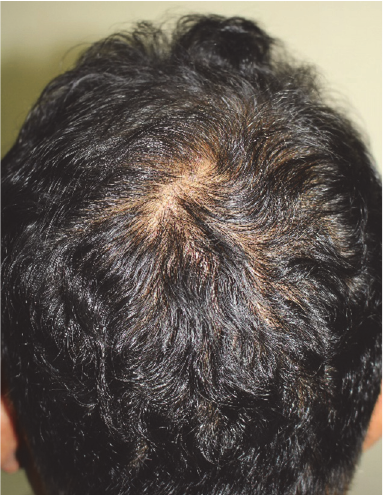
Figure 5: The patient had complete hair regrowth within 4